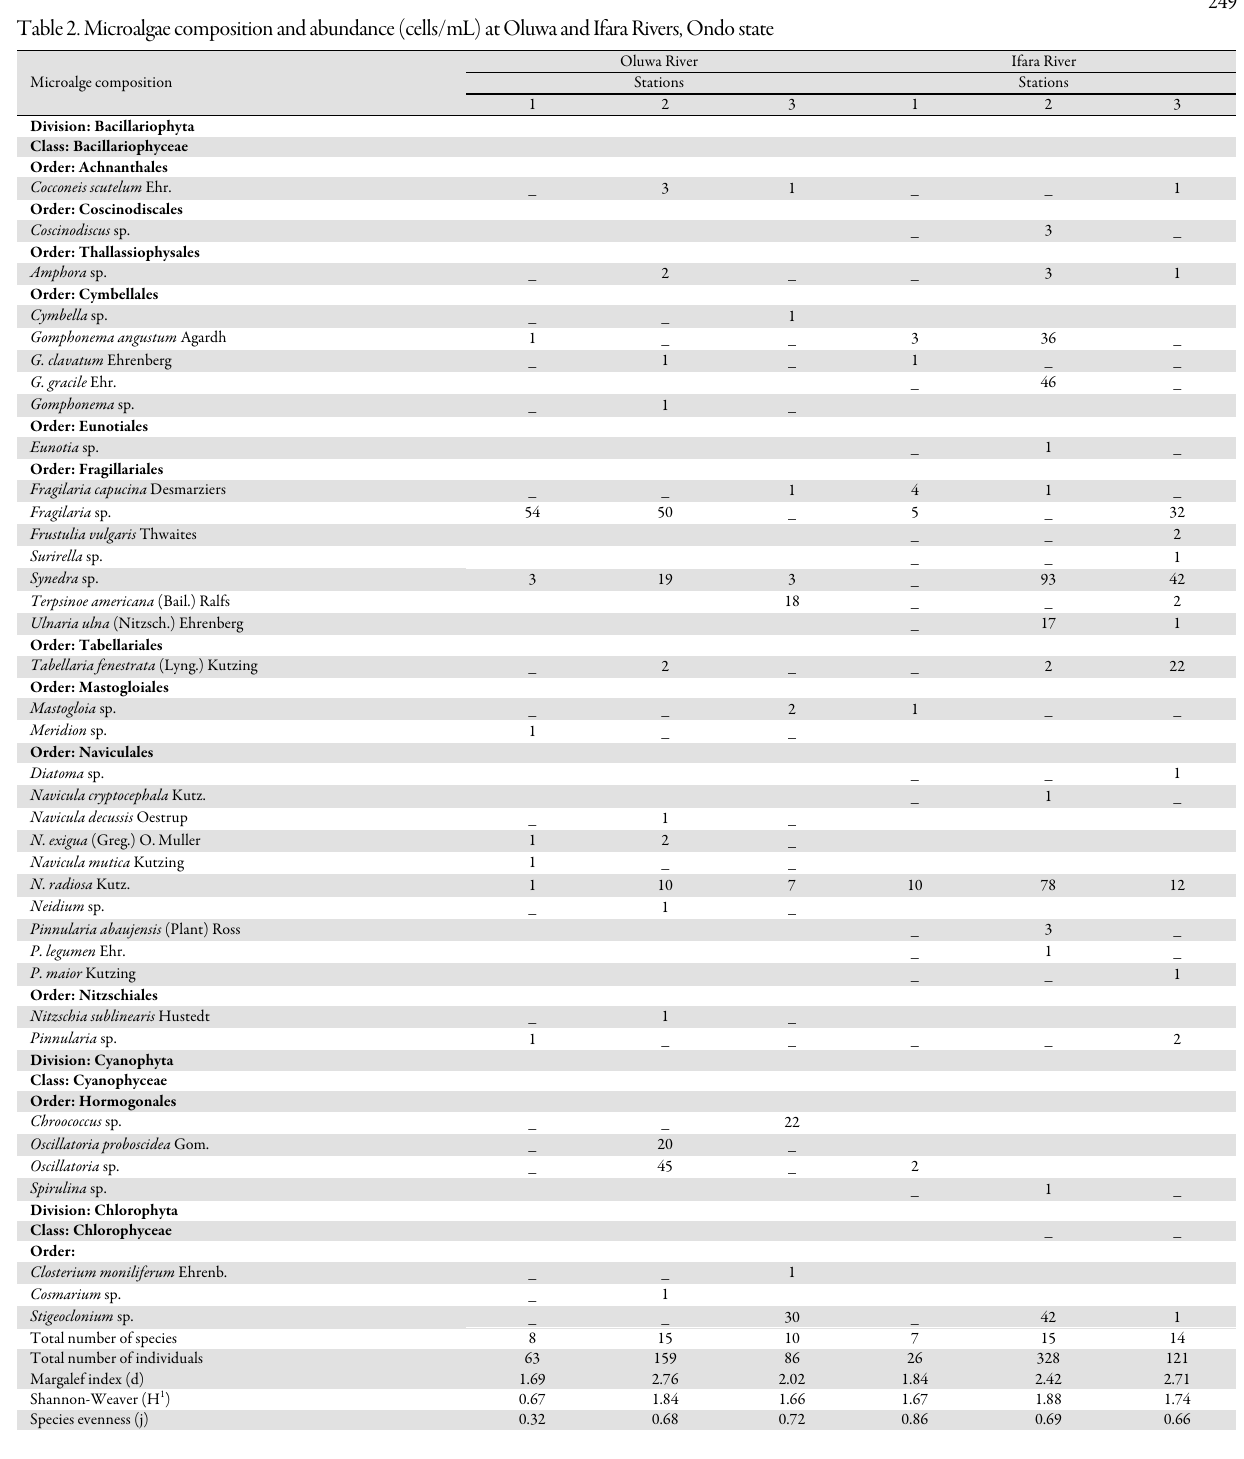
Table 2. Microalgae composition and abundance (cells/mL) at Oluwa and Ifara Rivers, Ondo state Microalge composition Class: Bacillariophyceae Order: Achnanthales Cocconeis scutelum Ehr. Coscinodiscus sp. Amphora sp. Cymbella sp.